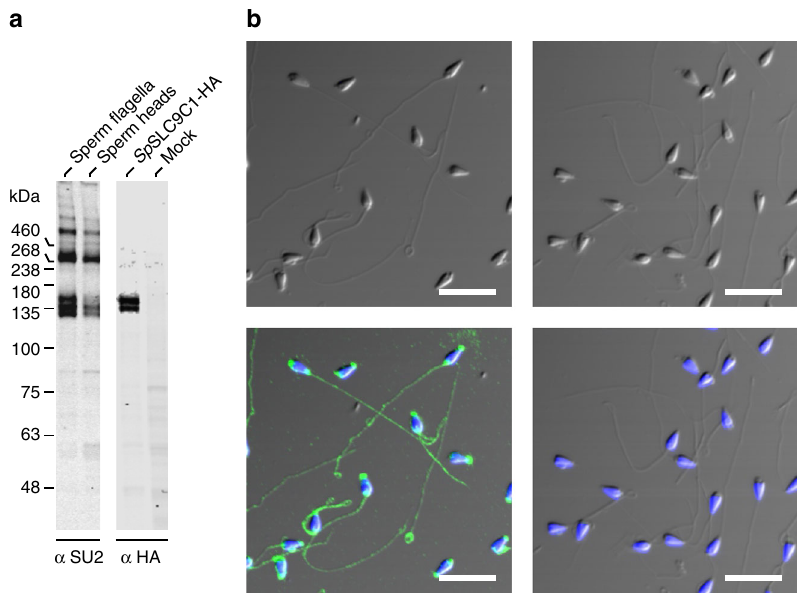
Fig. 6 Analysis of Sp SLC9C1 expression in sea urchin sperm. a Representative western blot using protein lysates from fl agella and heads of S. purpuratus sperm, from CHO cells heterologously expressing HA-tagged Sp SLC9C1 ( Sp SLC9C1-HA), and from non-transfected CHO cells (mock). Sp SLC9C1 in fl agella and heads was probed with the anti- Sp SLC9C1 antibody SU2 (left panel) and Sp SLC9C1-HA in CHO K1 cells was probed with an HA antibody (right panel, see also Supplementary Figure 8). b Immunocytochemical analysis of sperm stained with SU2 (left) and pre-immune serum control (right). Upper panels: bright- fi eld (DIC) microscopy. Lower panels: overlay of DIC and fl uorescence images ( Sp SLC9C1, green; nucleus stained with DAPI, blue). Scale bars represent 10 µ